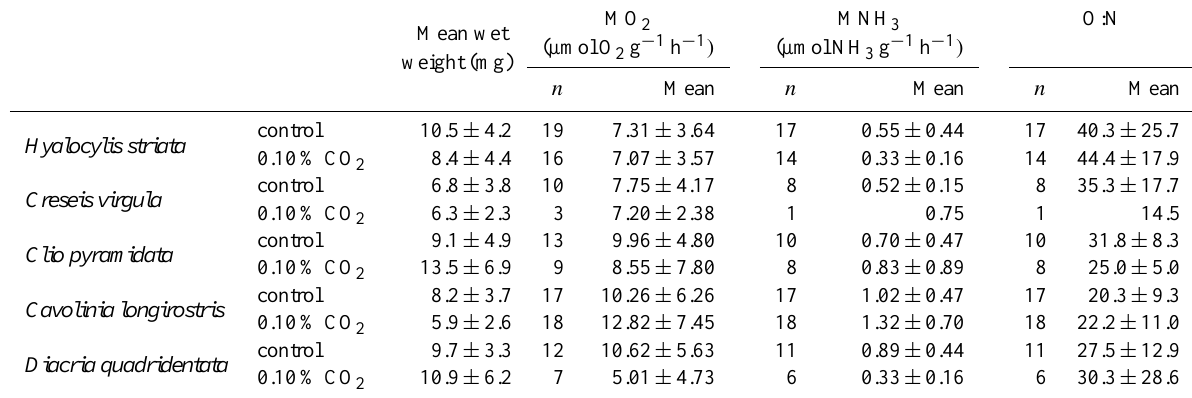
Table 4. The average size, oxygen consumption (MO 2 ± SD), and ammonia excretion (MNH 3 ± SD) of thecosome pteropods found in the Eastern Tropical Pacific at 20 ◦